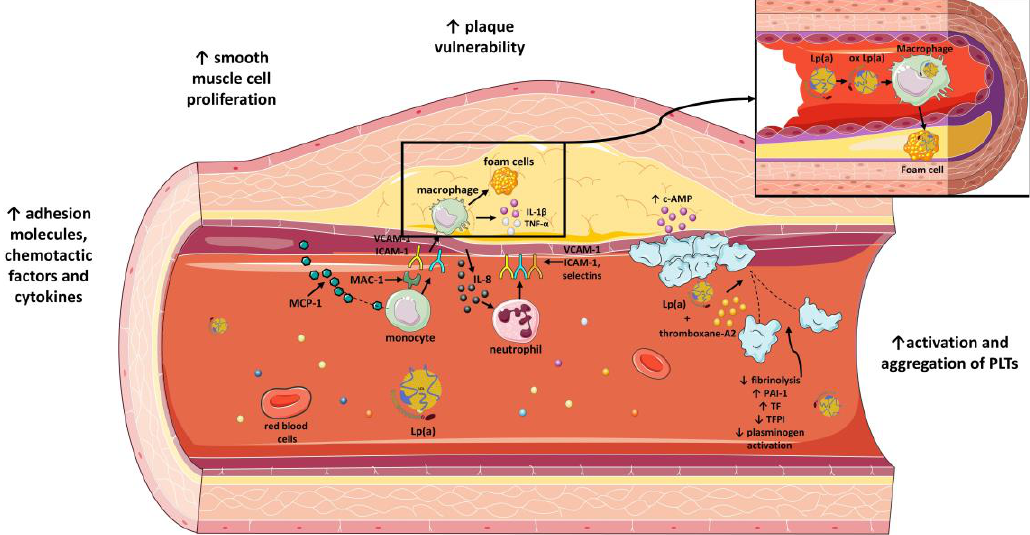
Figure 3. The impact of lipoprotein(a) on atherosclerotic process and atherothrombosis. Lp(a) increases atherosclerotic plaque vulnerability, vascular smooth muscle cell proliferation and adhesion of molecules, chemotactic factors and plasma cytokines. Moreover, Lp(a) enhances platelet activation and aggregation and inhibits fibrinolysis by inhibiting plasminogen activation. Lp(a) inhibits TFPI and enhances expression of TF. Moreover, Lp(a) induces increased expression of PAI-1. Lipo- protein(a): Lp(a); TFPI: tissue factor pathway inhibitor; PAI-1: plasminogen activator inhibitor-1;